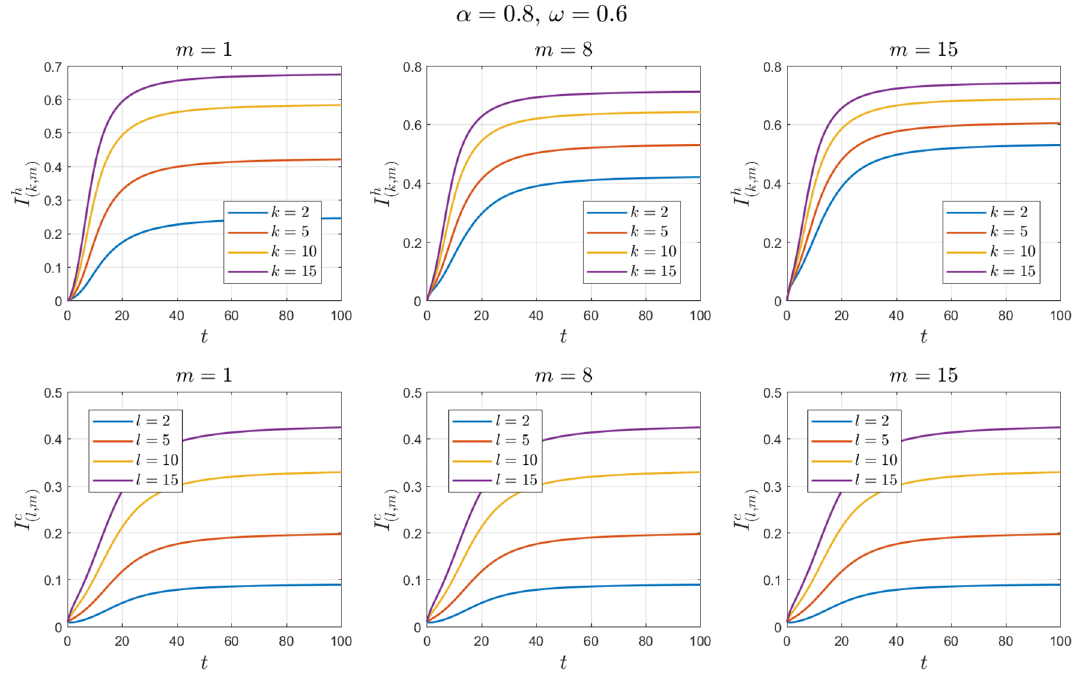
Figure 16. Numerical solutions of Example 5 for α = 0.8 and ω = 0.6 .